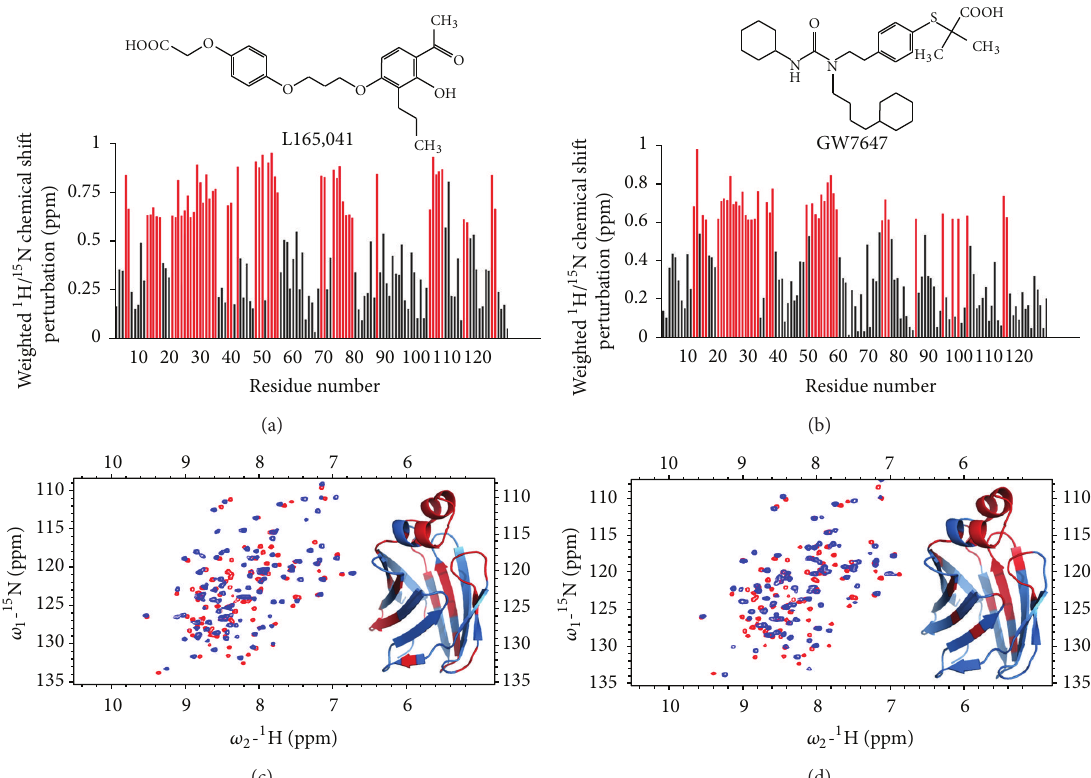
Figure 2: 1 HN and 15 N backbone amide chemical shift perturbations on human L-FABP produced by GW7647 and L165,041 drug binding. ((a)-(b)) A plot of the normalized chemical shift perturbations upon complex formation versus residue number. Red bars indicate highly affected residues ( > 0.6p.p.m perturbation). ((c)-(d)) 1 H- 15 N HSQC spectrum of apo-L-FABP (red) overlaid on top of the spectrum of holo- drug L-FABP (blue).The inset shows the highly affected residues ( > 0.6ppm perturbation) mapped onto the crystallographic structure of human L-FABP (PDB code: